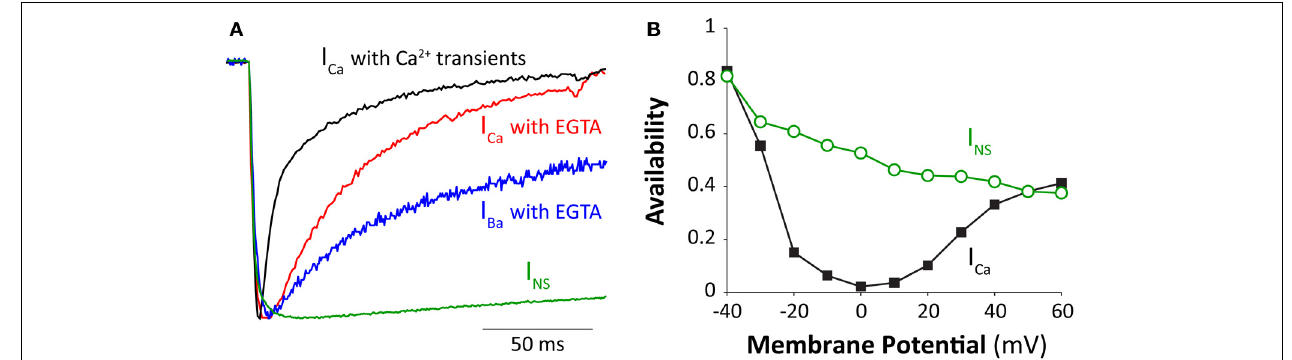
FIGURE 1 | Inactivation of cardiac Ca 2 + channel. (A) Normalized I Ca , I Ba , and I NS elicited by a square voltage pulse at room temperature to 0mV (except I NS at − 30mV to obtain comparable activation state). I Ca was recorded under both perforated patch (where normal SR Ca 2 + release and Ca 2 + transients occur) and ruptured patch conditions with cells dialyzed with 10mM EGTA (to prevent global Ca 2 + transients). I Ba was also recorded with ruptured patch (with 10mM EGTA in the pipette). Extracellular [Ca 2 + ] and [Ba 2 + ] were both 2mM and I NS was measured in